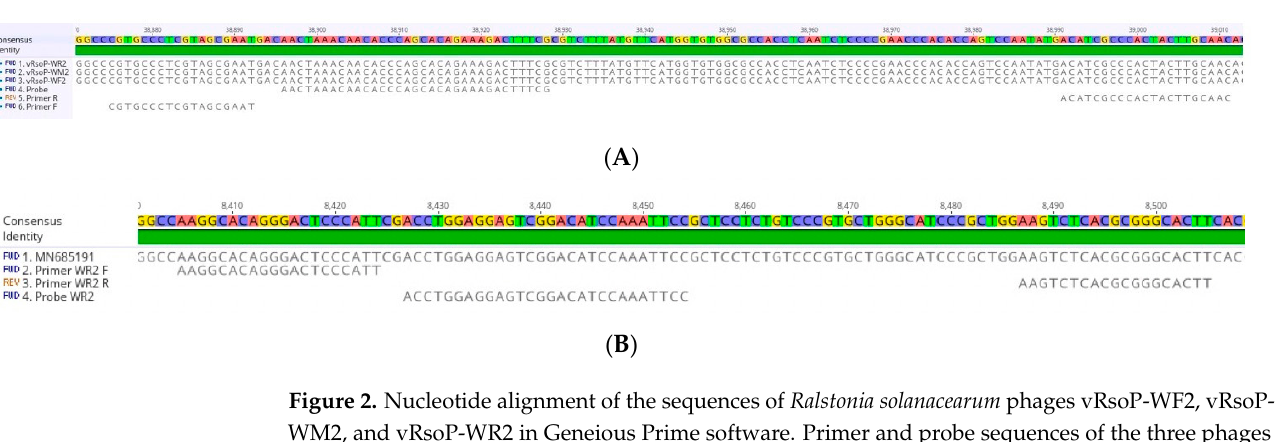
Figure 2. Nucleotide alignment of the sequences of Ralstonia solanacearum phages vRsoP-WF2,